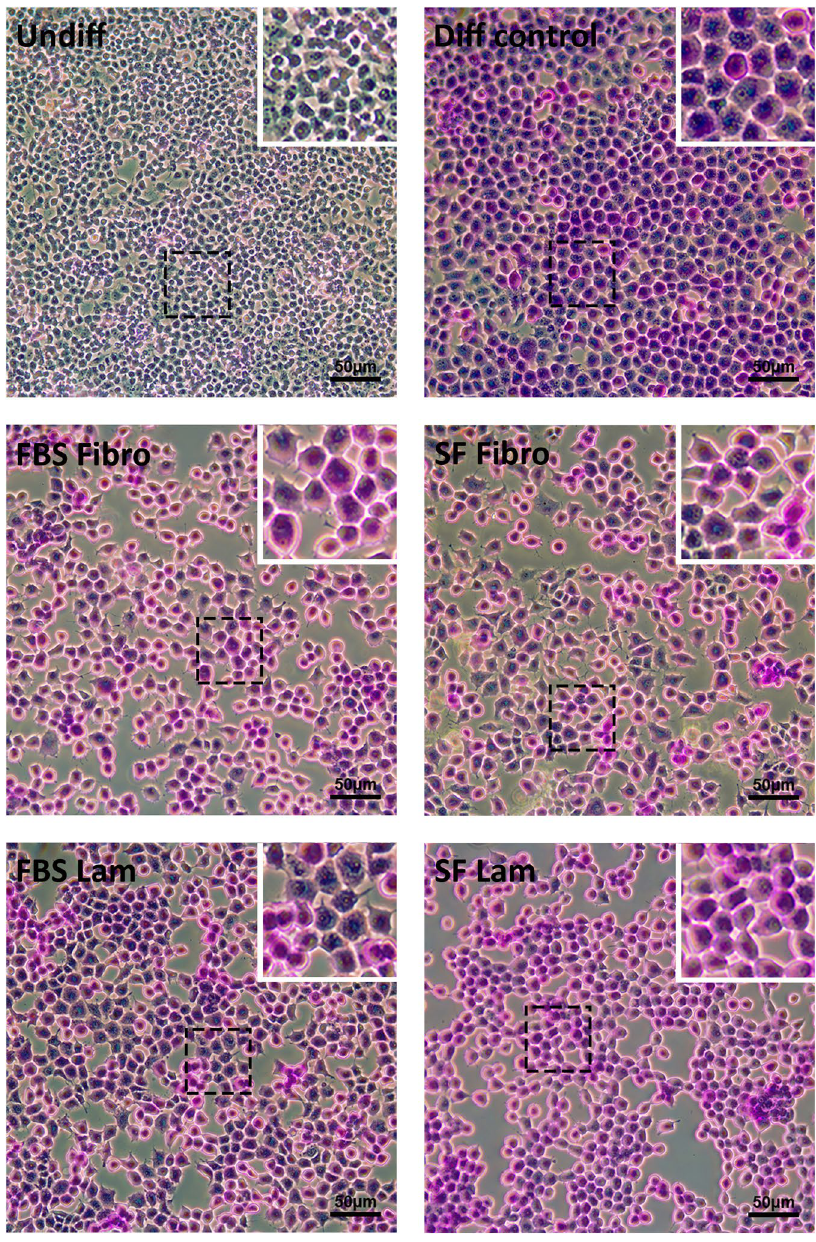
Figure 6. Glycogen storage potential in undifferentiated AR42J-B13 cells and cells subjected to differentiation- inducing conditions on day 5, assessed by Periodic acid-Schiff staining. Undiff - undifferentiated cells; Diff control - differentiation control, with FBS, on plastic; FBS Fibro - differentiation medium, with FBS, on fibronectin; SF Fibro - differentiation medium, serum-free, on fibronectin; FBS Lam - differentiation medium, with FBS, on laminin; SF Lam - differentiation medium, serum-free, on laminin. Scale bar = 50 µ